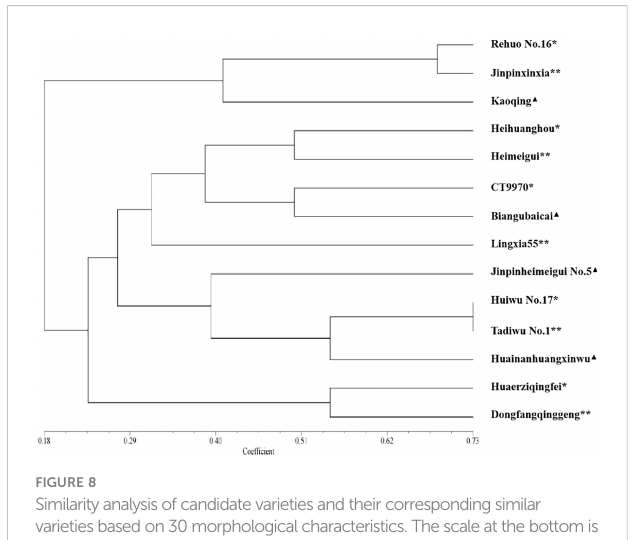
FIGURE 8 Similarityanalysisofcandidatevarietiesandtheircorrespondingsimilar varietiesbasedon30morphologicalcharacteristics.Thescaleatthebottomis thesimilaritycoef fi cient.*:candidatevarieties;**:varietiesscreenedbySSR fi ngerprintdatabase; ▲